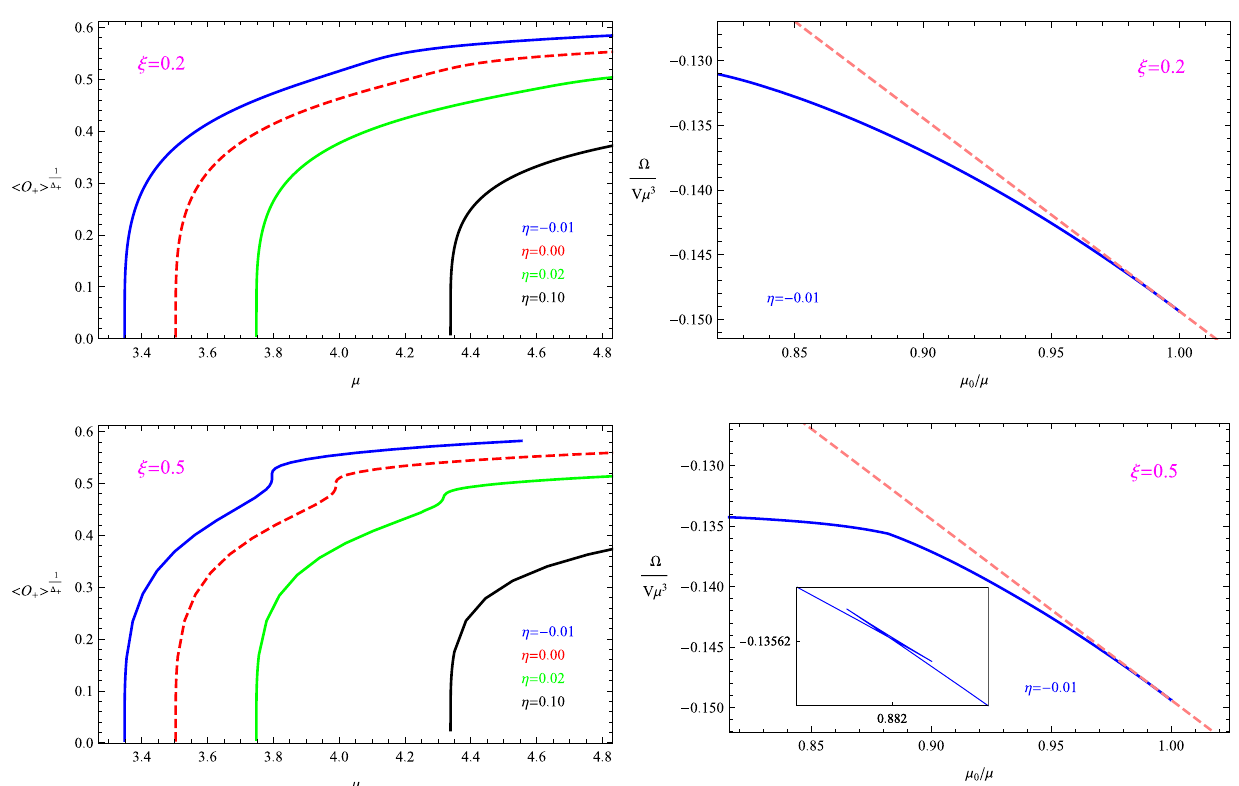
i.e., η = − 0 . 01 (blue), 0 . 00 (red dotted), 0 . 02 (green) and 0 . 10 (black), respectively. For the right two panels, the two lines in each panel cor- respond to the superconducting phase (blue) and normal phase (pink dotted) in the case of η = − 0 . 01,